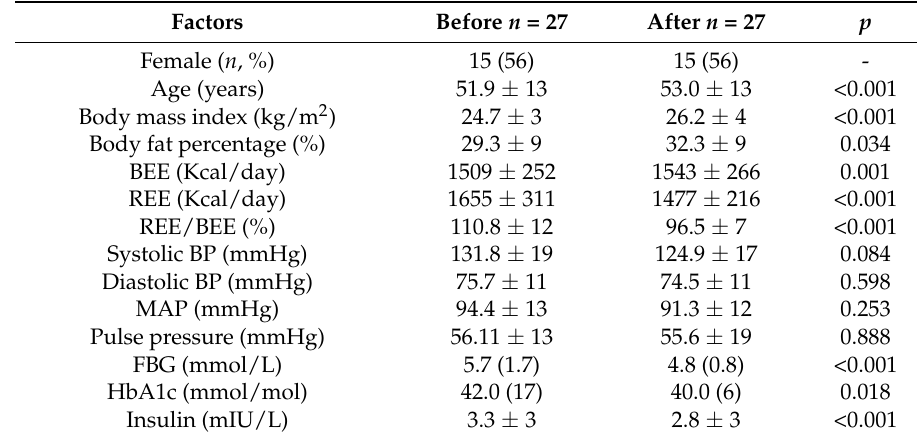
Table 2. PPGL patients before and after